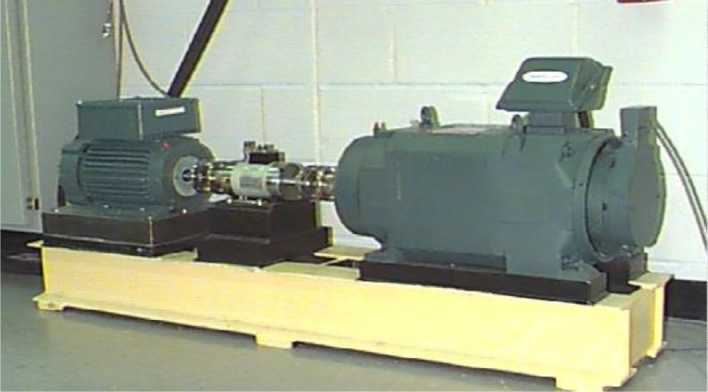
Experimental set-up.